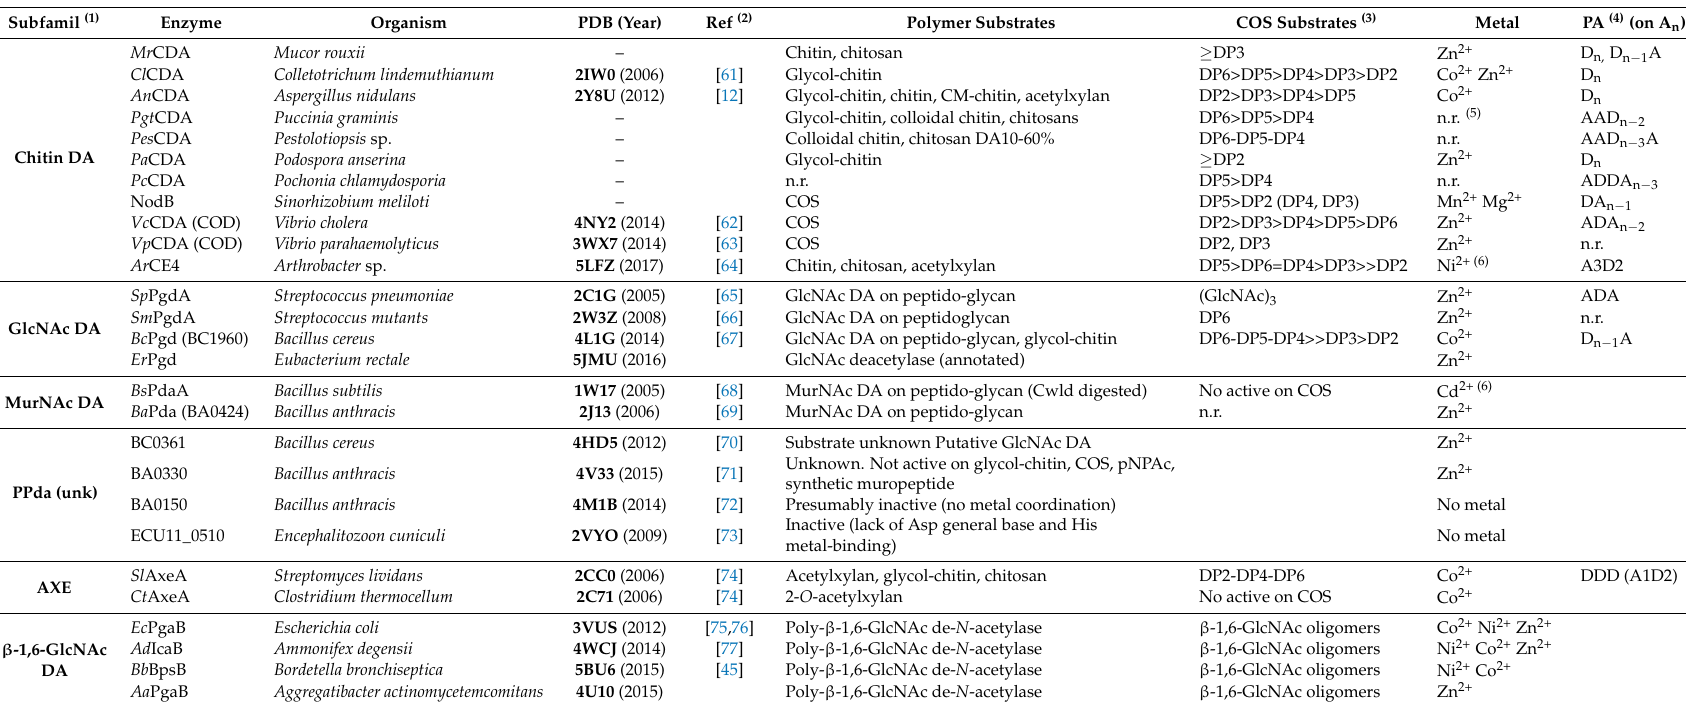
Table 1. CE4 enzymes active on chitooligosaccharide and GlcNAc-containing